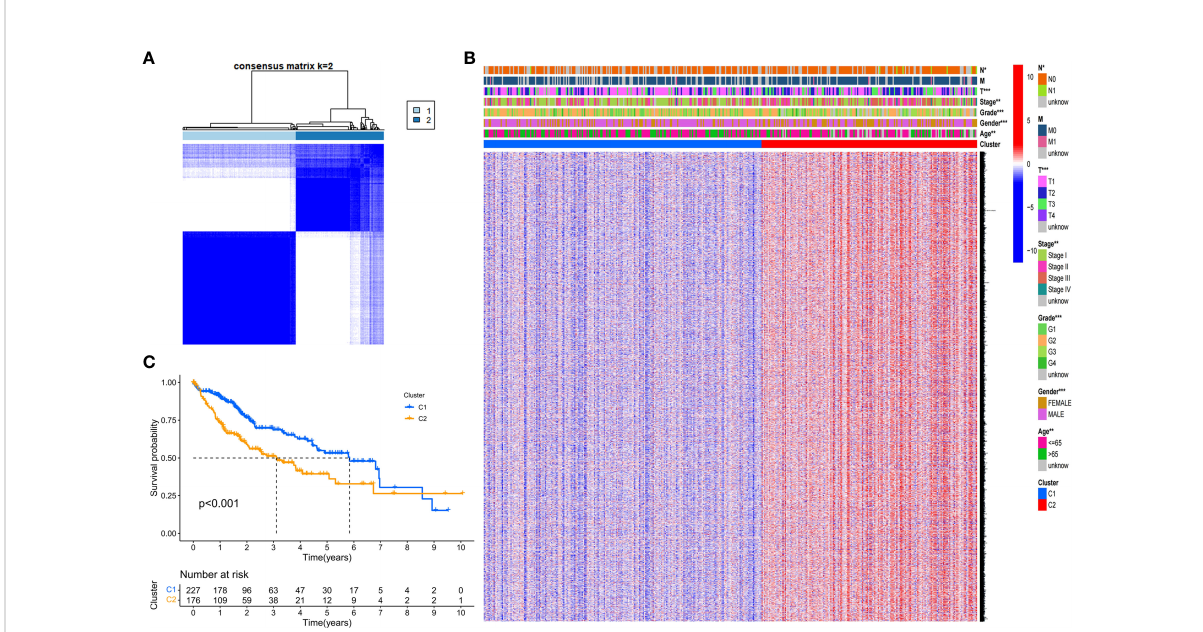
FIGURE 2 Tumor classi fi cation based on the DEGs. (A) HCC patients were strati fi ed into two clusters in the consensus clustering matrix (k = 2). (B) A heatmap shows gene expression pro fi le and the clinical characters in the two clusters. (C) Kaplan – Meier survival curves show the OSs of the two clusters. * P <0.05; ** P <0.01; *** P